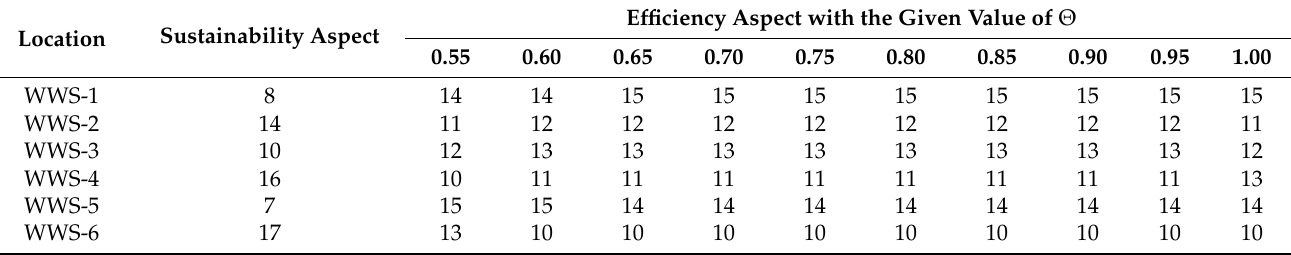
Table A11. The efficiency–sustainability rank of the WWS